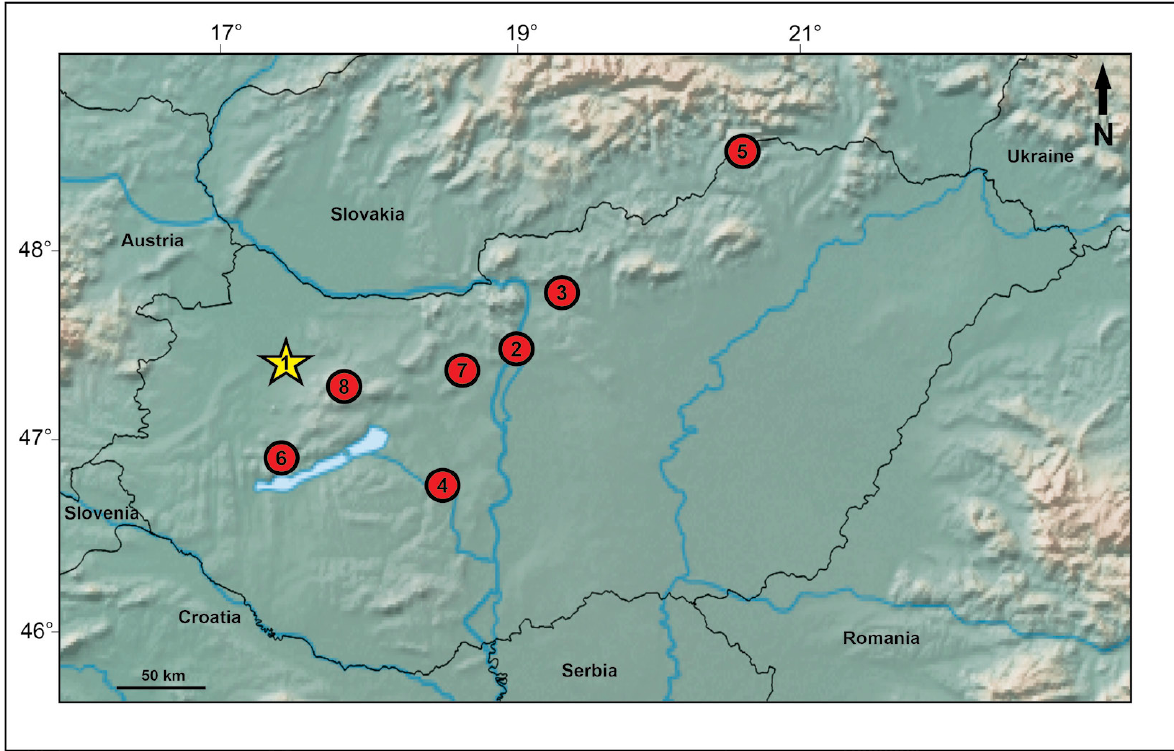
Figure 1. Distribution of Apocheiridium ferum (yellow star = new locality) and Cheiridium museorum (yellow star = new locality, red circles = previous records) in Hungary. 1: Pápa, Várkert-Castle Park, 47.3332°S, 017.4659°W (new locality). 2: Budapest, 47.4719°S, 019.0503°W (Tömösváry 1883). 3: Püspökhatvan, 47.7667°S, 019.3667°W (Novák 2013). 4: Simontornya, 46.7539°S, 018.5475°W (Pillich 1914). 5: Szin, Szelcepuszta, Aggtelek National Park, 48.5198°S, 20.6041°W (Novák 2018). 6: Tapolcza, 46.8825°S, 017.43667°W (Tömösváry 1883). 7: Vál,